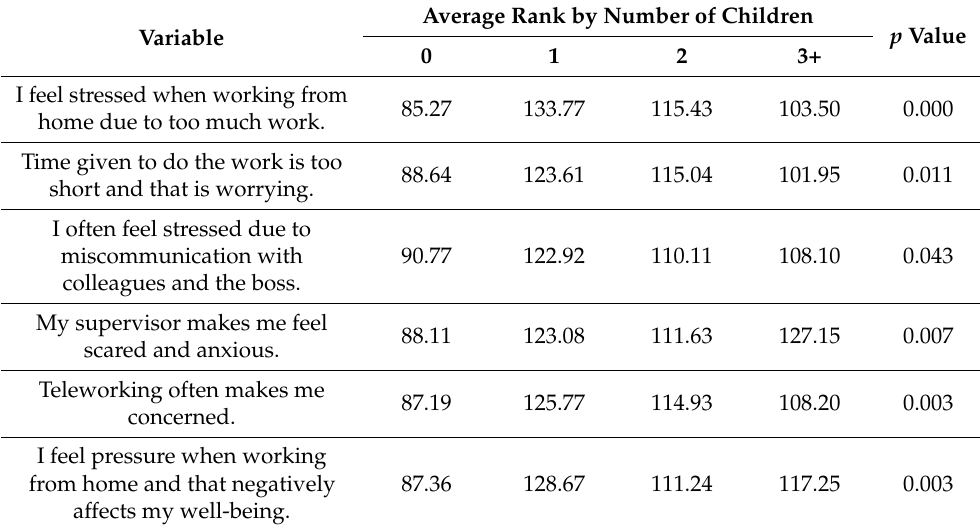
Table 6. Causes of stress when working from home by number of children in the family. Average Rank by Number of Variable